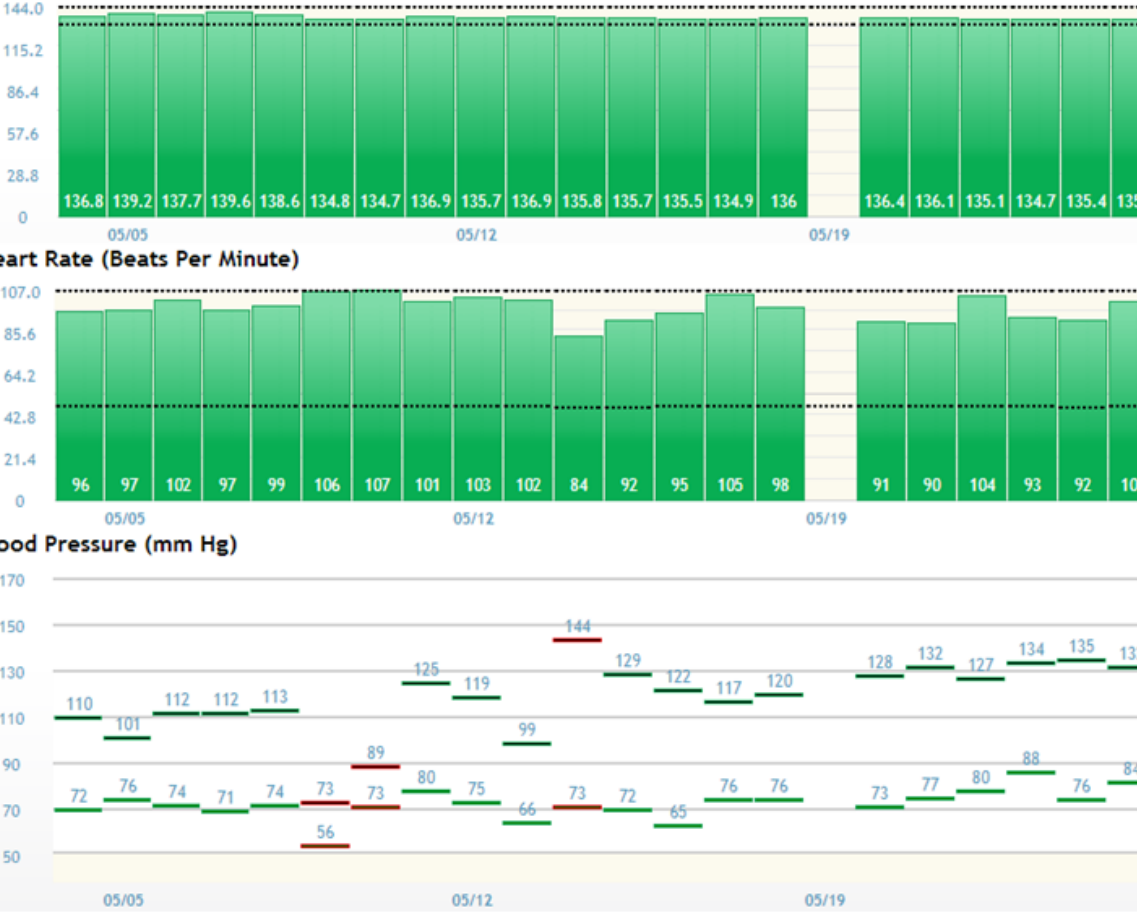
Zan et alJMIR MHEALTH AND